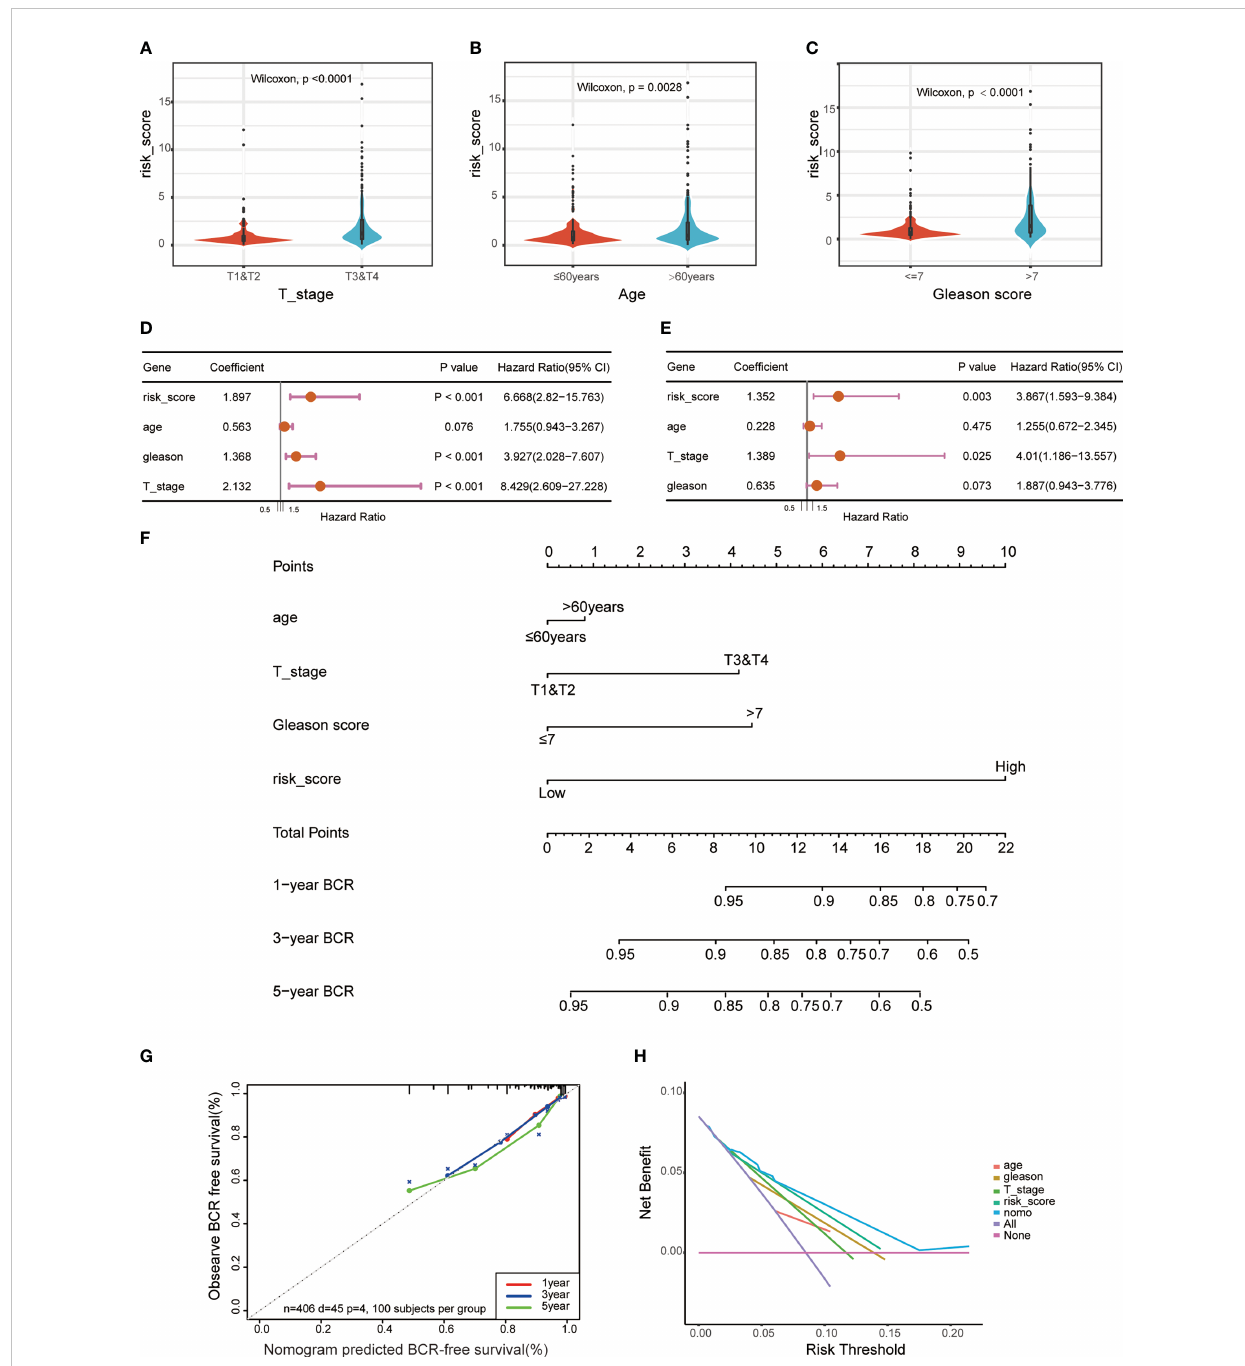
FIGURE 4 Correlations between risk models and clinical characteristics based on the TCGA PRAD dataset. Violin plot shows different ERS risk score between different pathological stage (A) , age (B) , and Gleason score (C) of the TCGA PRAD cohort. Univariate (D) and multivariate (E) Cox regression analyses were used to explore the prediction of ERS-associated risk signature in the TCGA PCa dataset. (F) A nomogram with ERS- related risk scores, age, T stage, and Gleason scores for predicting the probability of BCR-free survival in patients. (G) The calibration curves of the nomogram. (H) The decision curve analysis (DCA) for median BCR-free survival time